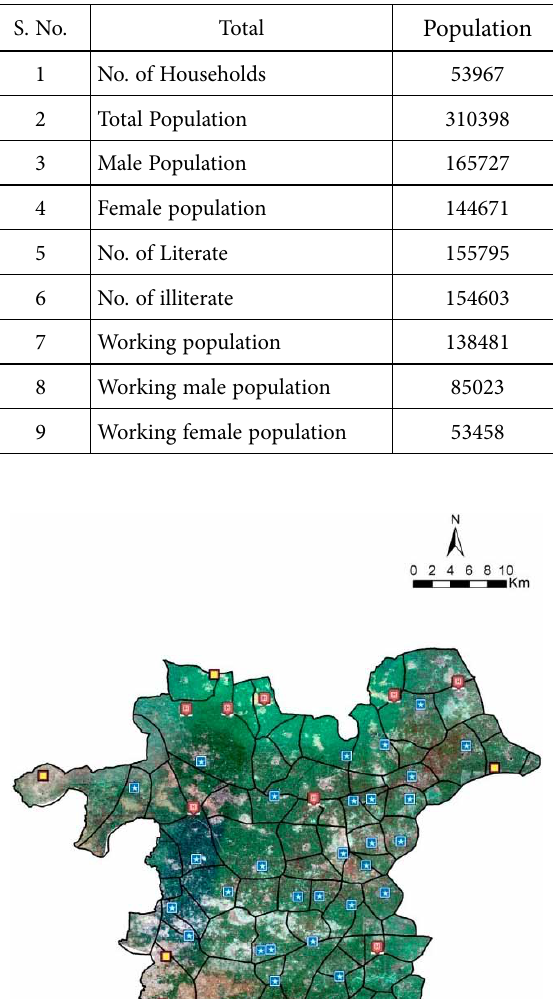
Table 2. The details of different group of population